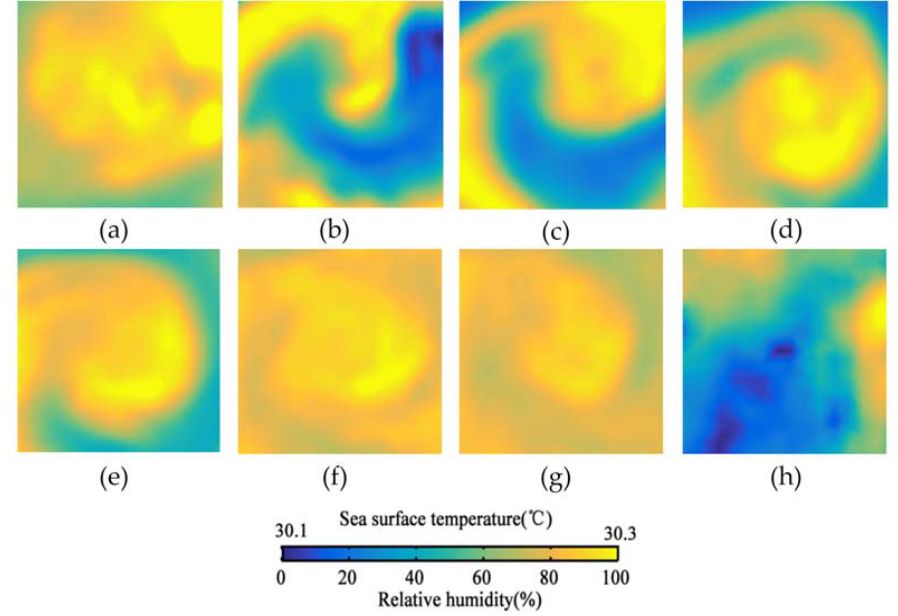
Figure 6. Images of atmospheric and oceanic variables at each level: ( a ) 100 hPa, ( b ) 200 hPa, ( c ) 300 hPa, ( d ) 500 hPa, ( e ) 700 hPa, ( f ) 850 hPa, ( g ) 1000 hPa, and ( h ) sea surface. In each image, the colors in ( a – g ) represent relative humidity (%), and those in ( h ) represent the SST (°C).